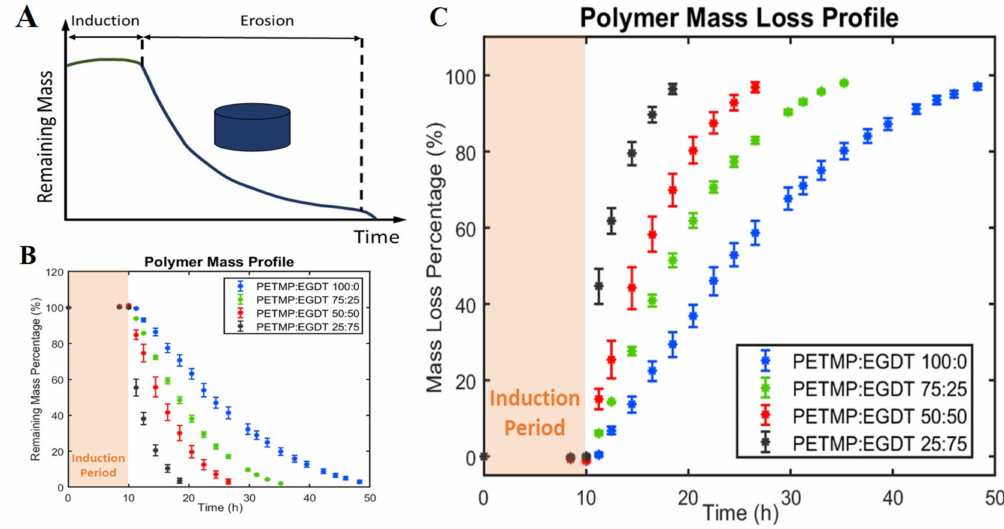
Figure 1. The e ff ect of crosslinking ratio (polymer compositions) on mass loss profiles. ( A ) Schematic mass loss profile of thiol-ene polyanhydrides showing an induction period, and subsequent erosion. ( B ) Remaining mass percentage and ( C ) fractional mass loss percentage of thiol-ene-based polyanhydrides. Increasing the EGDT in polymer networks leads to faster erosion rates. However, changing the mole ratios of PETMP over EGDT did not change the induction period. All experiments were conducted at 25 ◦